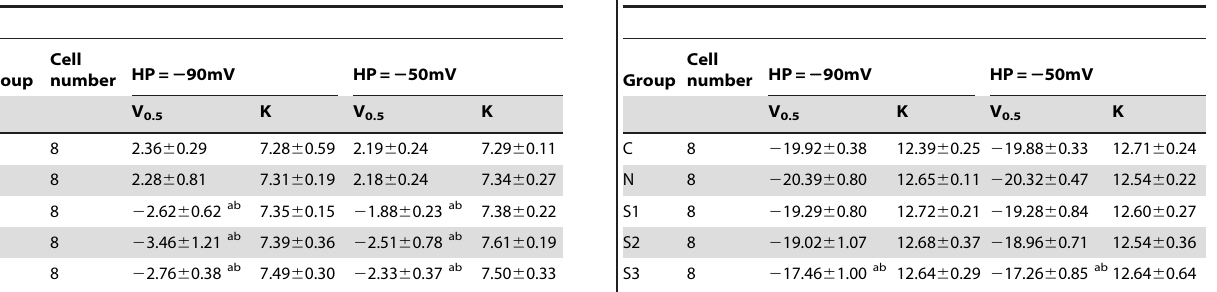
Table 2. The voltage of half-activation (V 0.5 ) and slope factor (K) at HP of 2 90mV and 2 50Mv.